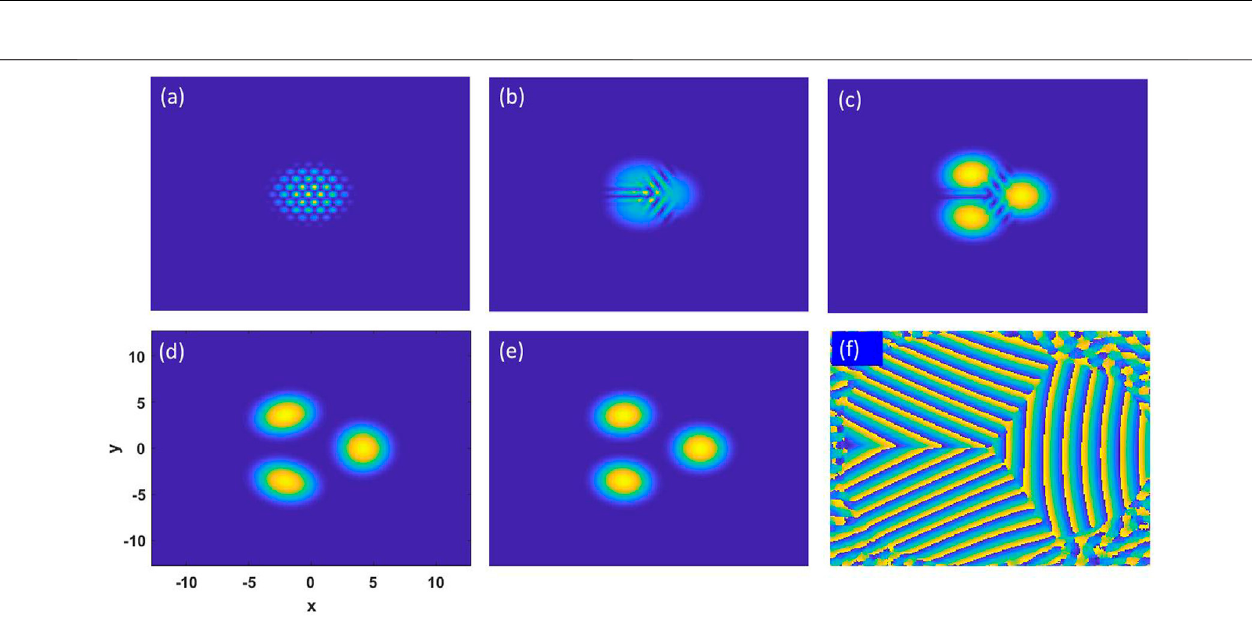
FIGURE 2 | Typical ground-state structures of an SU(3) spin – orbit-coupled BEC as a function of SU(3) spin – orbit coupling and gradient magnetic fi eld in the absence of rotation. (A) – (D) Density distributions of component 1 for fi xed SU(3) spin – orbit coupling κ (cid:1) 3 and for different gradient magnetic fi elds: (A) B (cid:1) 0, (B) B (cid:1) 1, (C) B (cid:1) 2,and (D) B (cid:1) 3. (E) Densitydistributionofthesystemfor B (cid:1) 3and κ (cid:1) 5. (F) Thecorrespondingphasedistributionof (D) .Otherparametersare fi xedas c 0 (cid:1) 100,